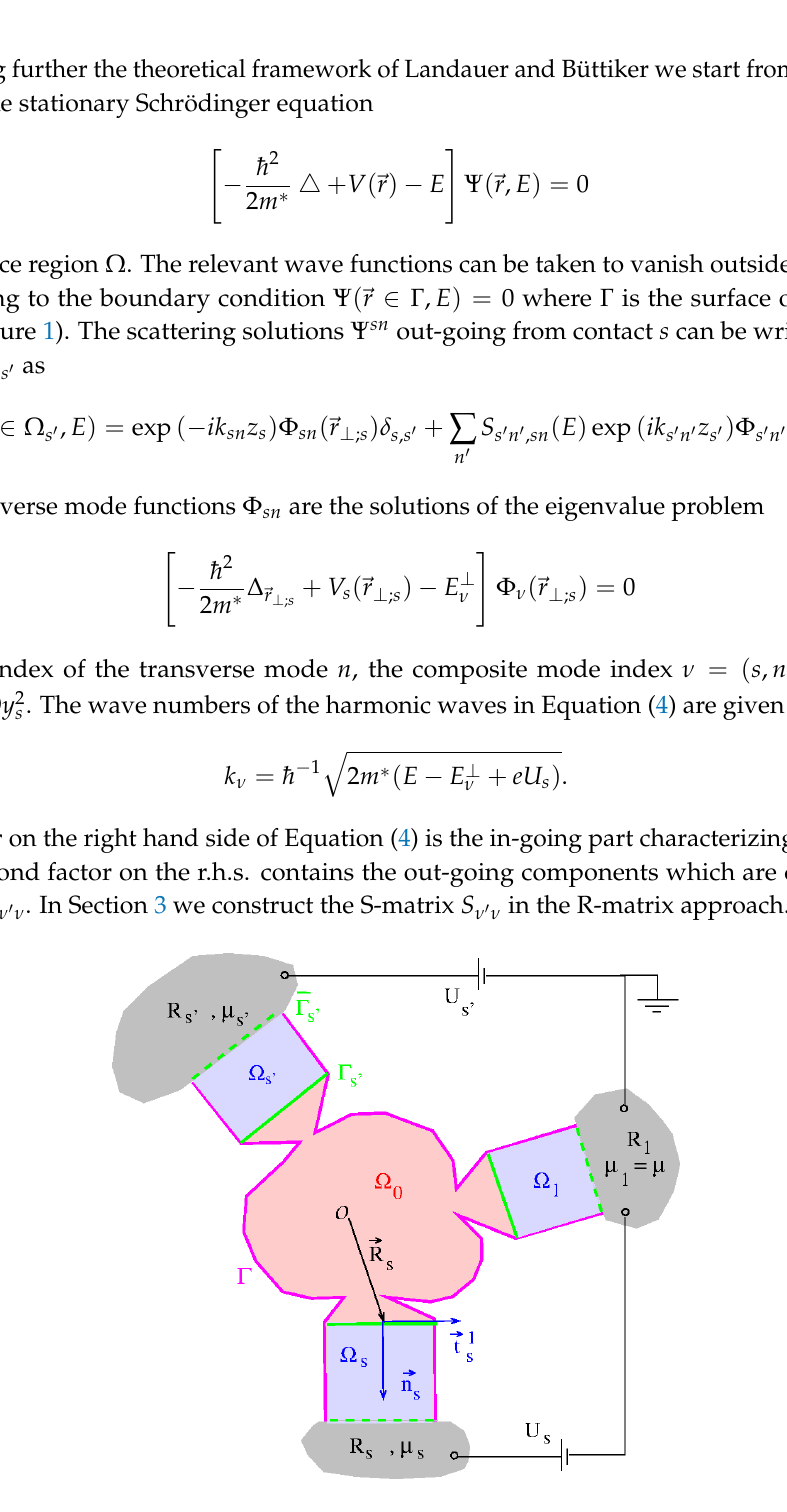
Figure 1. Idealized multi-terminal system: N = 3 terminals denoted with the index s are connected to the central scattering volume Ω 0 (red). Each terminal is associated, first, with a charge carrier reservoir R s defining the chemical potential µ s (grey) of the carriers. Second, it is associated with a contact region Ω s (blue) in which coherent scattering states are formed. In green we plot the interfaces the Ω s and Ω 0 (solid) as well as the interfaces ¯ Γ s between the Ω s and R s (dashed). The coherence volume Ω of the scattering states comprises the set union of Ω 0 and all Ω s . Here Γ is the surface of Ω excluding the ¯ Γ s